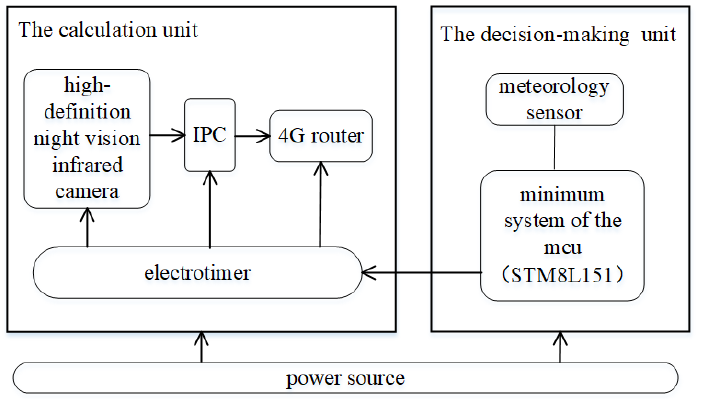
Figure 4. The structure of the hardware.